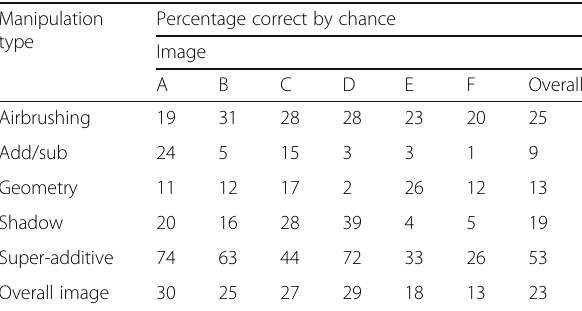
Table 4 Chance performance in location task by manipulation type and overall based on mean number of subjects choosing the manipulated region in the original version of the image Manipulation